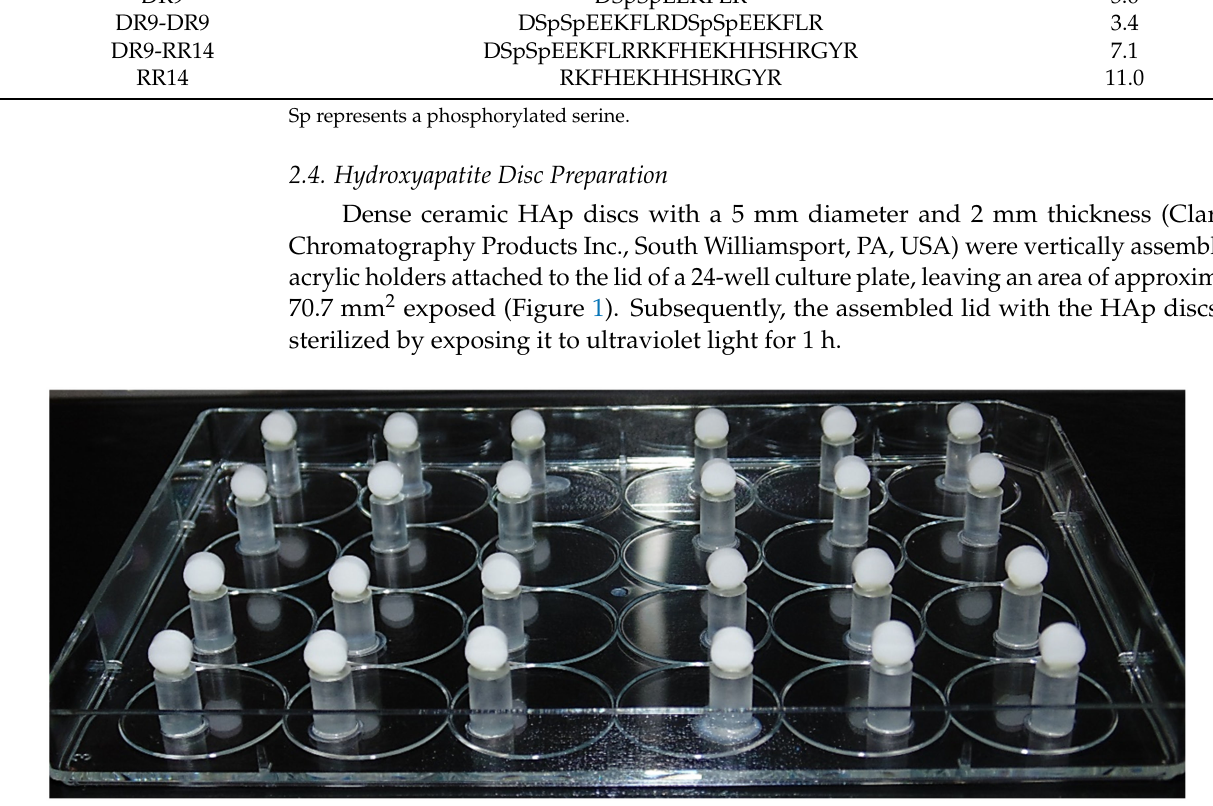
Figure 1. Photograph of hydroxyapatite discs assembled on a cell-culture plate